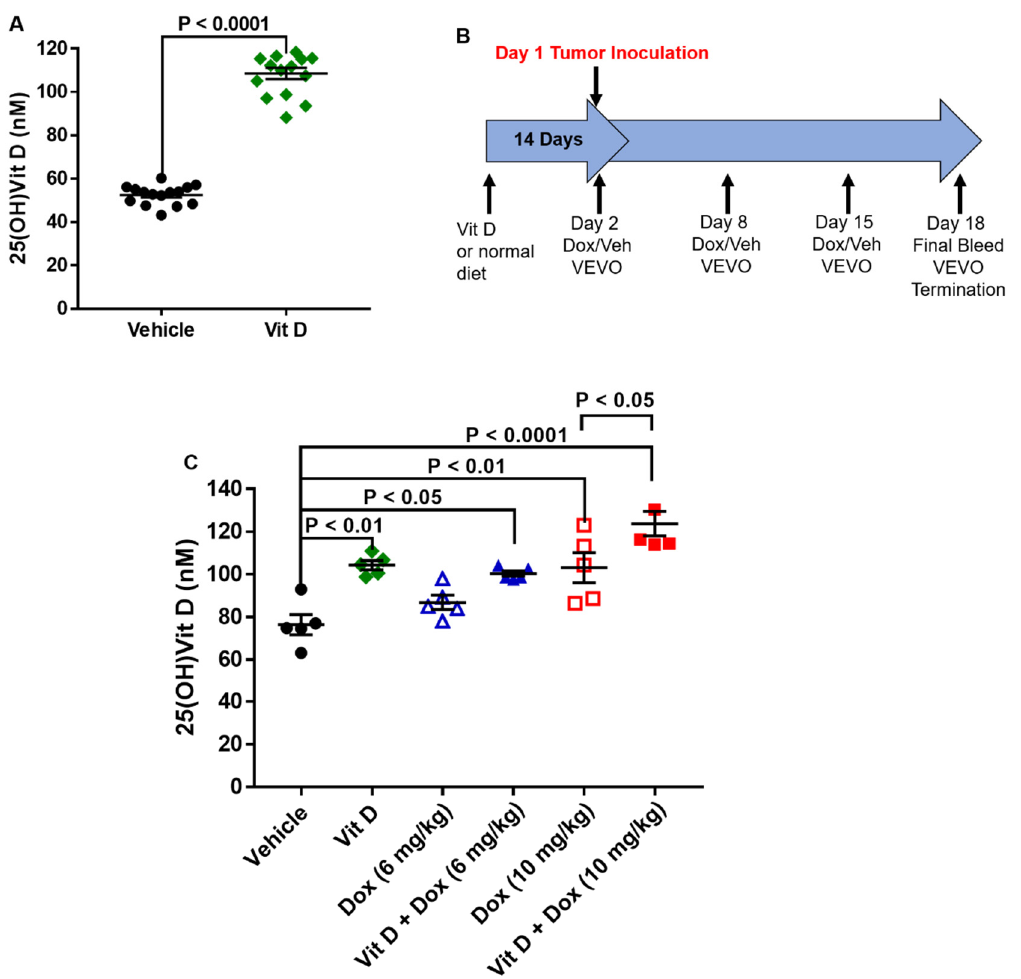
Figure 1. Levels of 25-hydroxyvitamin D in mice with vehicle or vitamin D-supplemented diet and doxorubicin treatment. ( A ) Levels of 25-hydroxyvitamin D (25(OH)Vit D) in the plasma collected after 14 days of 10,000 IU/kg additional vitamin D provided in the supplemented diet (15 mice per group). p < 0.0001. ( B ) Experimental timeline of vitamin D supplementation during doxorubicin (Dox) exposure. ( C ) Levels of 25(OH)Vit D in plasma collected 2 weeks after Dox treatment initiation (5 mice per group).